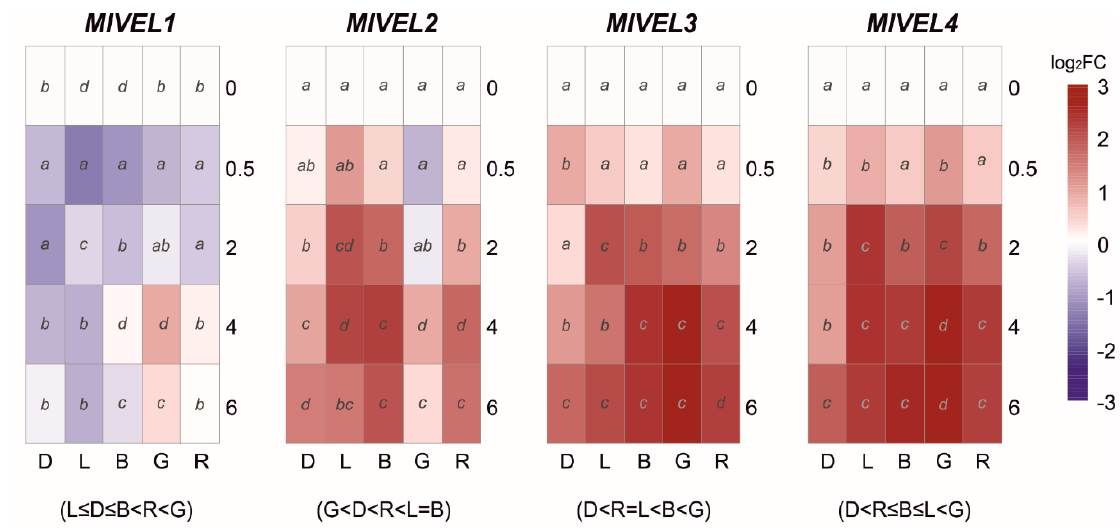
Figure 4. The heat maps represent changes in the relative gene expression of four velvet ( VEL ) coding genes under continuous darkness (D), daylight (L), blue (B), green (G), or red (R) light at different time points. The scale is log 2 of fold change mean values after normalization against 0 h post illumination using the 2 − ∆∆ CT method. Red color represents a higher relative expression than 0 h post illumination, and blue color represents a lower relative expression. Data were analyzed between light sources containing all times (shown at the bottom between brackets), and by light source between times (letters) by analysis of variance; the mean values with the same letter are not significantly different ( p ≤ 0.05) according to Duncan’s multiple range test.